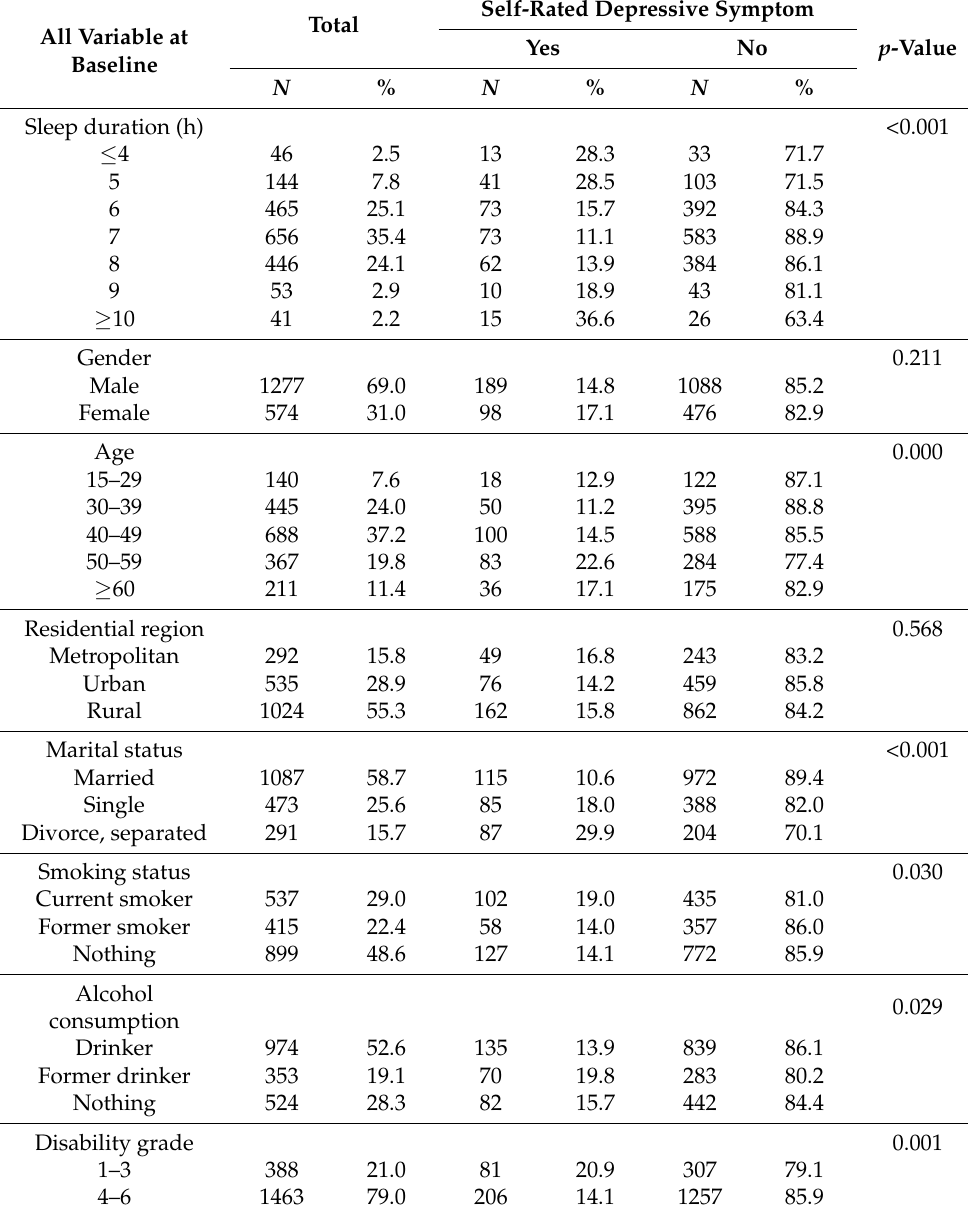
Table 1. The descriptive statistics of all variables at baseline